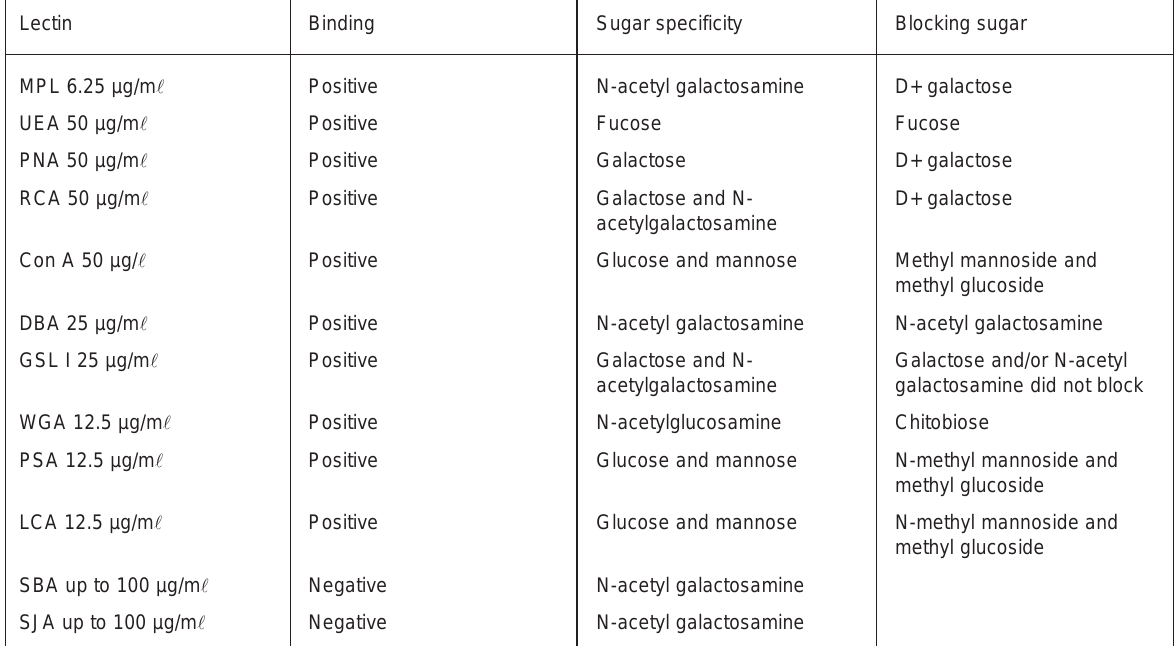
TABLE 1 Results of lectin binding Lectin